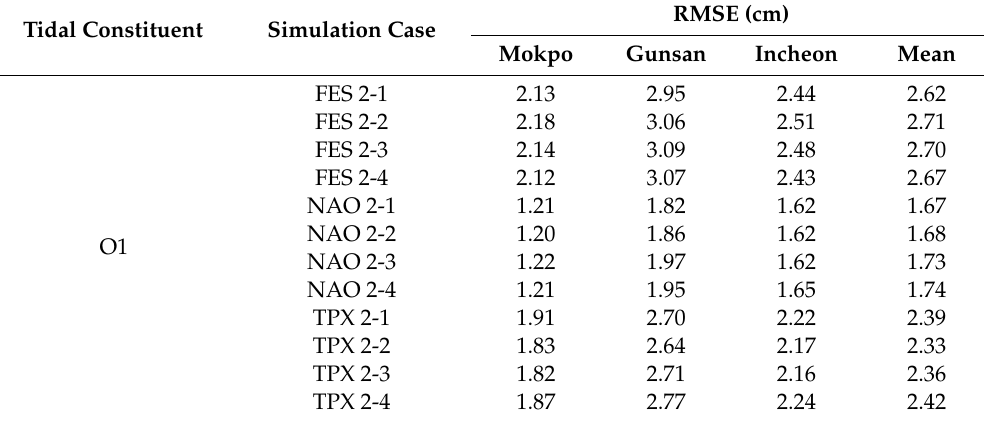
Table A9. RMSE results obtained from non-uniform roughness bottom for